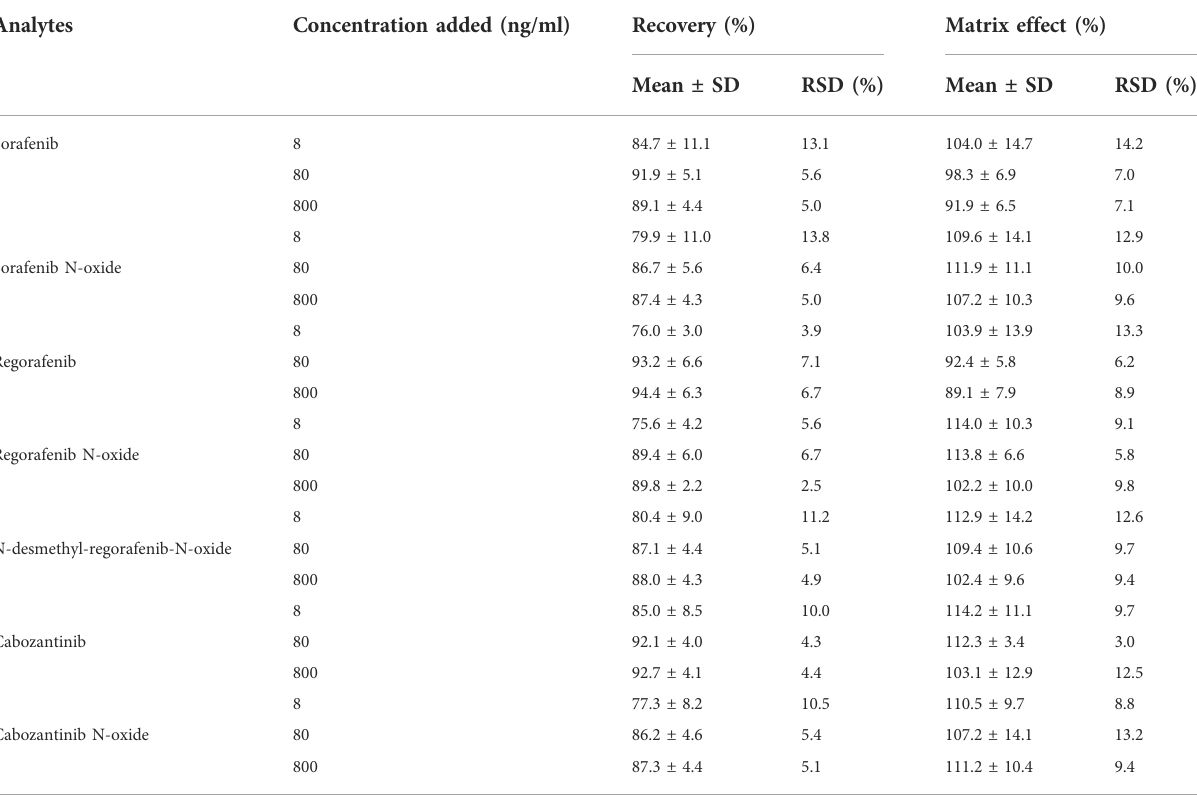
TABLE 2 Recovery and matrix effect of each analyte in SD rat plasma ( n = 6). Analytes